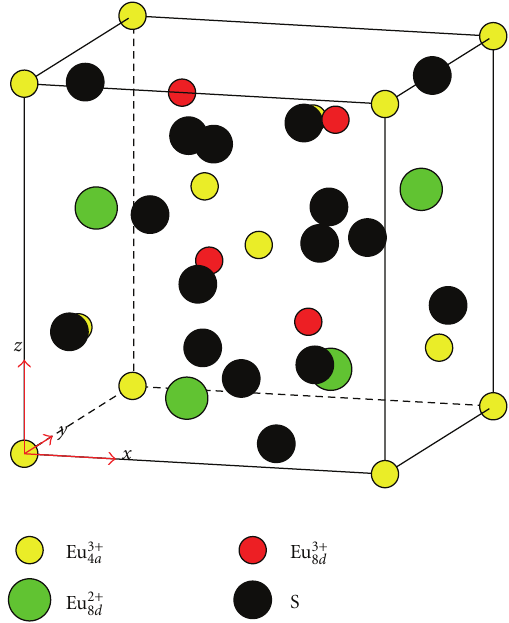
Figure 87: Crystal structure of a low temperature phase of Eu 3 S 4 . Small yellow balls: Eu 3+ ions in the 4 a crystallographic positions. Large green balls: Eu 2+ ions in the 8 d positions, small red balls: Eu 3+ ions in the 8 d positions. Large black balls: S ions